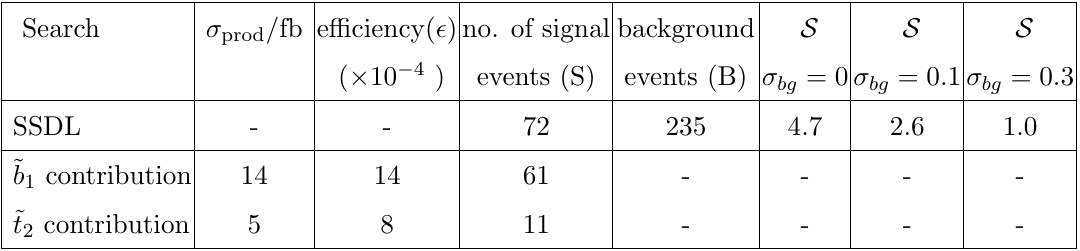
q B + (cid:27) 2 B 2 . See text bg